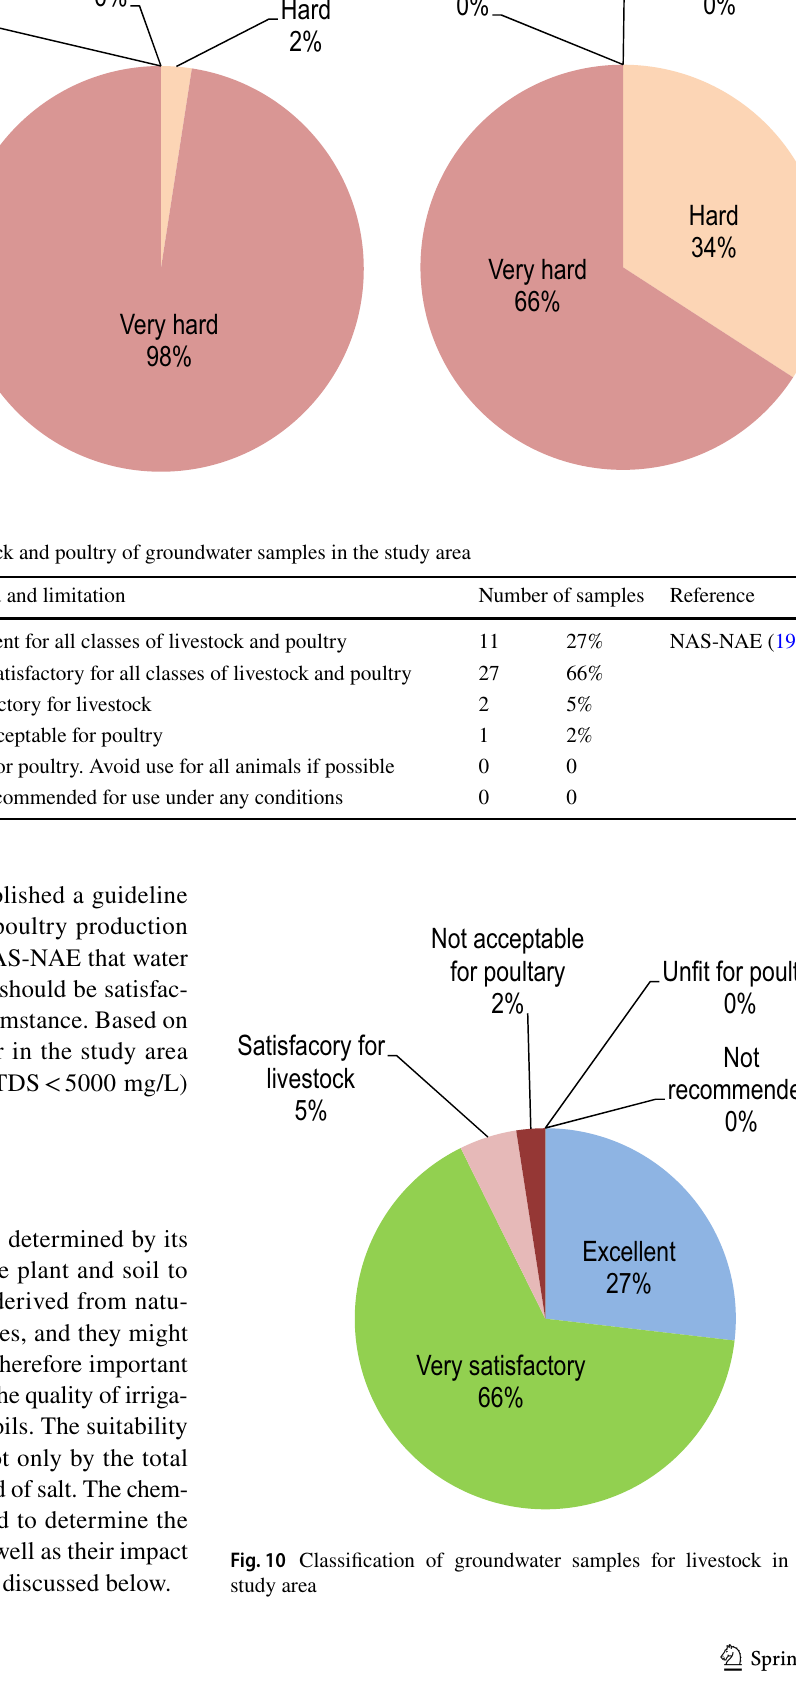
groundwater samples based on TH. Left based on Durfor and Becker (1964) and right based on Todd and Mayers (2005)